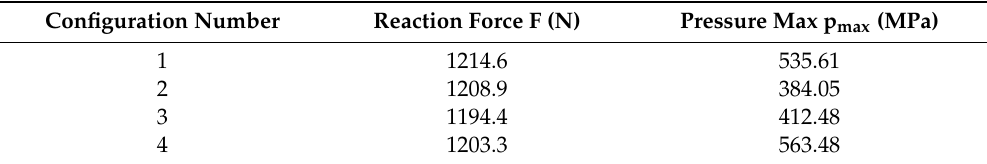
Table 3. FEM results.